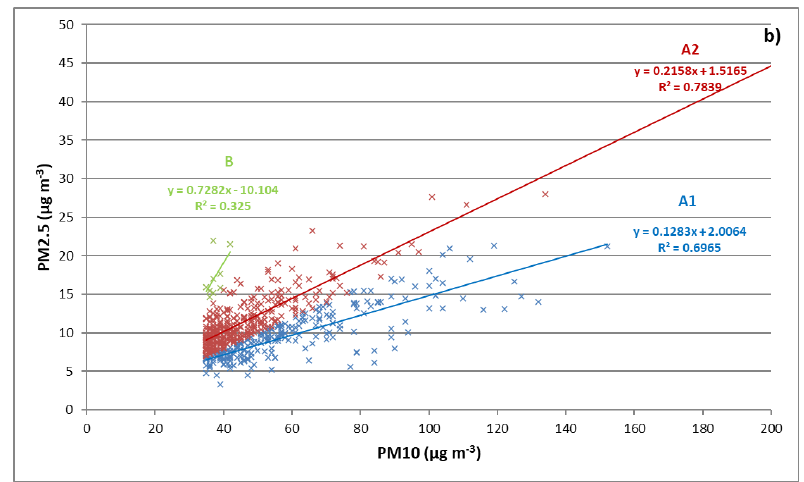
Figure 9. Scatter plot showing the correlation (linear regression) between daily PM 2.5 and PM 10 data in PR from 2000 to 2020 for ( a ) all cases and ( b ) dusty cases ( [ PM 10 ] ≥ 35 µ g.m − 3 ) according to the following ratios: A1 = PM 2.5/ PM 10 < 0.2, A2 = 0.2 ≤ PM 2.5/ PM 10 < 0.4, B = 0.4 ≤ PM 2.5/ PM 10